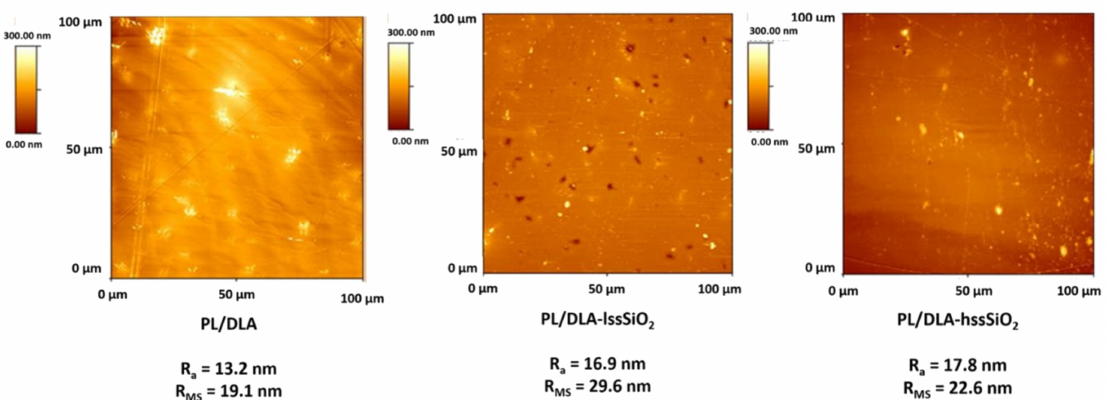
Figure 4. Topography of the nanocomposite materials and the polymer foil (reference sample) with characteristic parameters R a and